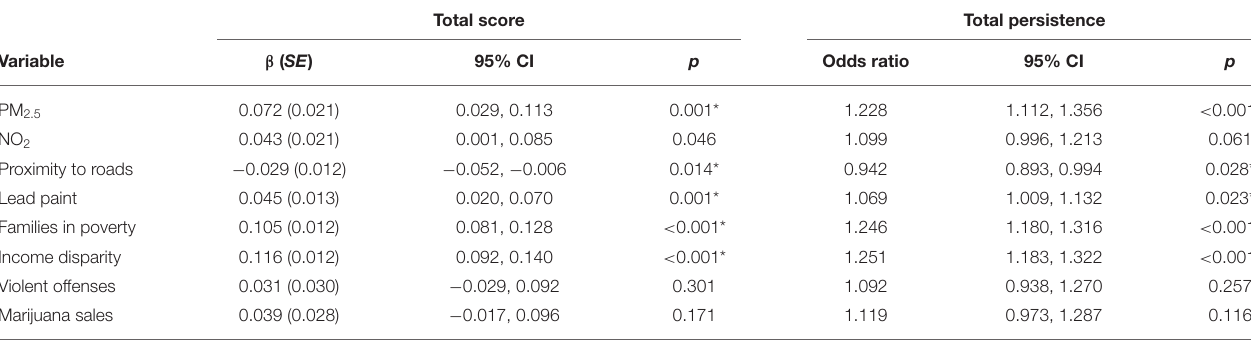
TABLE 3 | Associations between candidate mediators and PLE-total